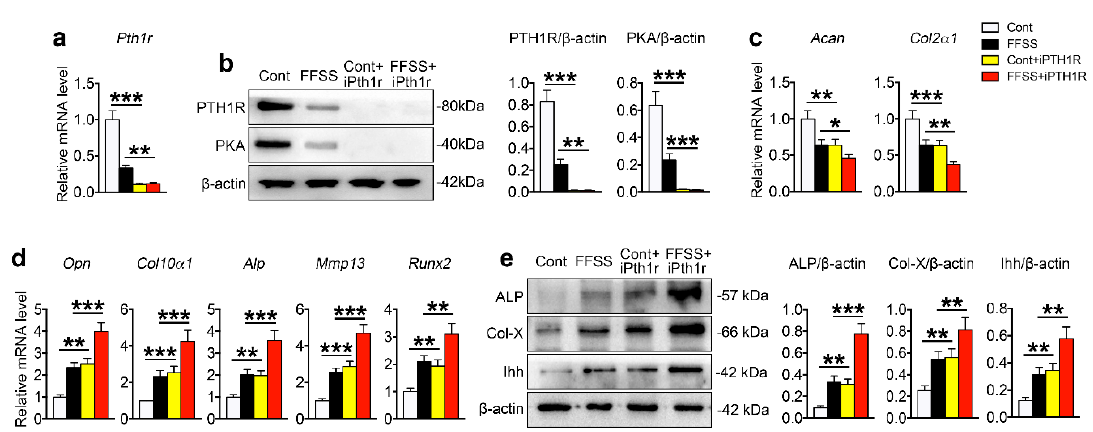
Figure 6. PTH1R expression level in the deep zone cells of TMJ cartilage influenced the terminal differentiation. The deep zone cells were isolated from the mandibular condylar cartilage of the 3-week-old SD rats and were transfected with Pth1r siRNA to knockdown its expression. ( a ) The expression of Pth1r . ( b ) The protein expression of PTH1R and PKA. ( c , d ) The expression of Acan , Col2a1 , Opn , Col10a1 , Alp , Mmp13 , and Runx2 . ( e ) The protein expression of ALP, Col-X, and Ihh. n = 3. Results are represented as the mean ± SD. * p < 0.05, ** p < 0.01, *** p < 0.001.